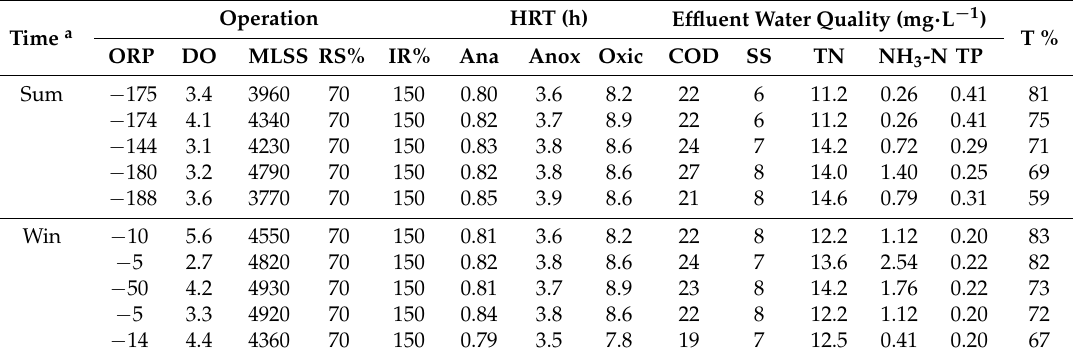
Table 2. Data mining outputs for the process design in Case-2